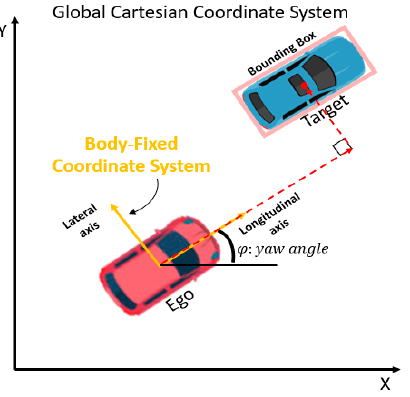
Figure 4. Global Cartesian coordinate system and body-fixed coordinate system for the representation of vehicle states.